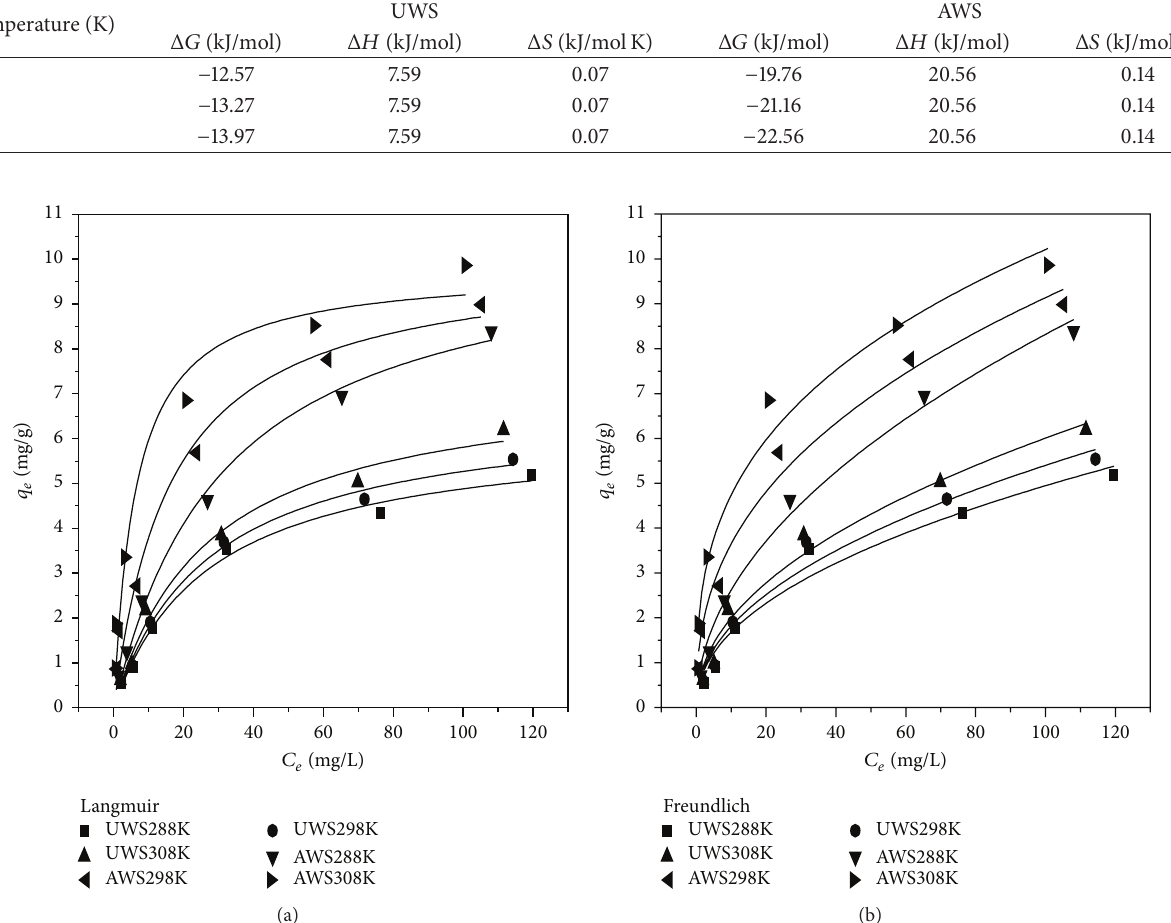
Figure 6: Langmuir and Freundlich adsorption isothermal curves of Cu(II) on wheat straw (conditions: adsorbent dose = 5 g/L, contact time = 6 h, pH = 5, and stirring rate = 150